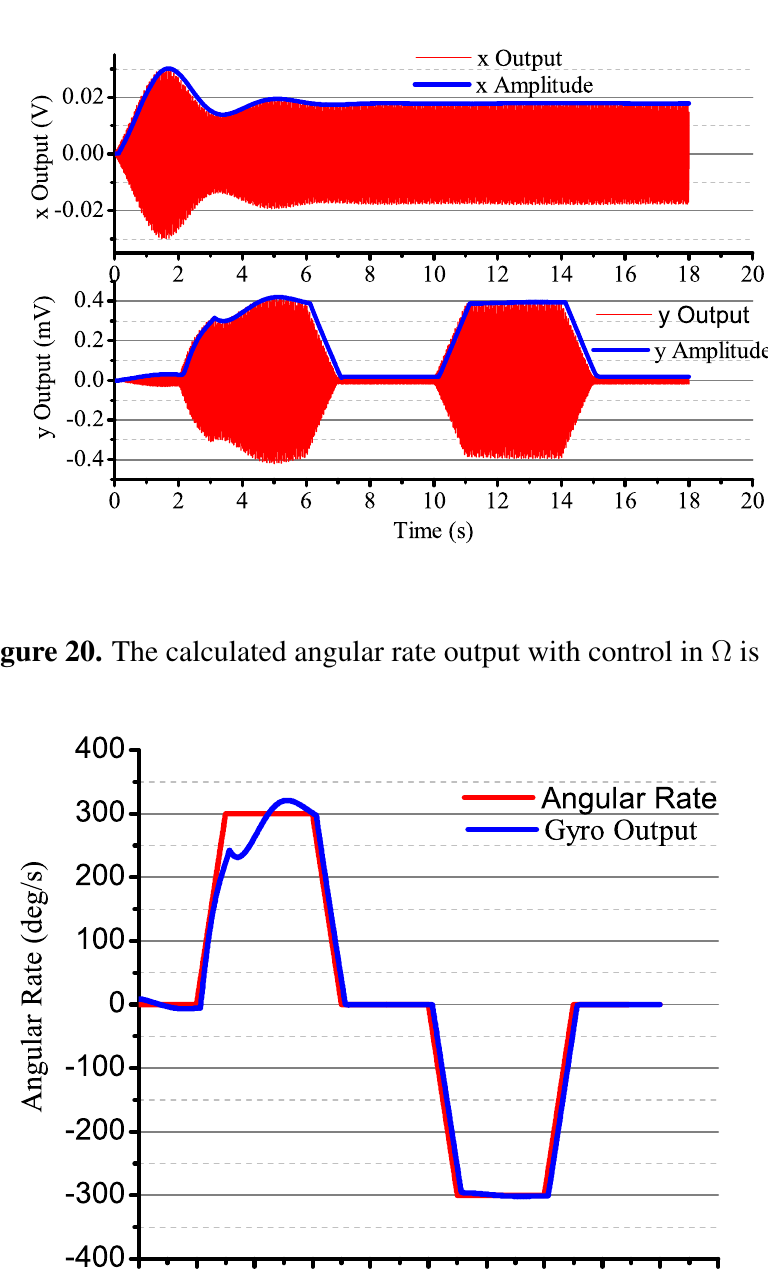
Figure 19. The gyro’s output with control in Ω is square.